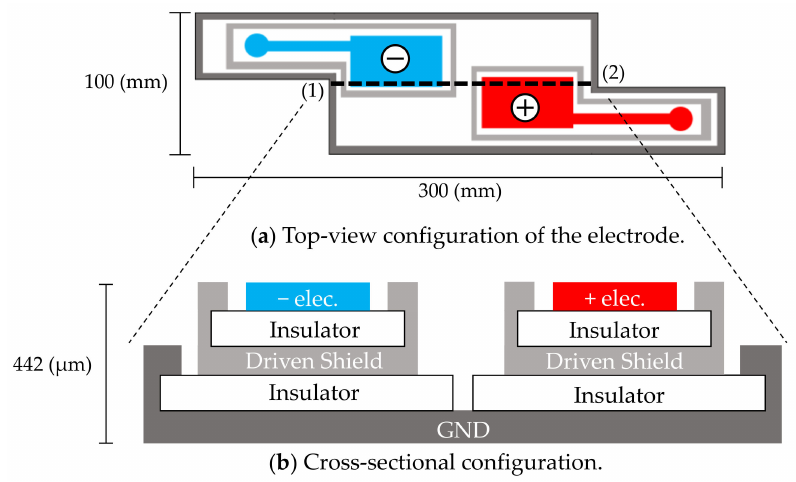
Figure 1. In-pillow capacitive cloth electrodes. ( a ) Top-view configuration of the electrodes. ( b ) Cross-sectional configuration of ( a ) along the dotted line (1)–(2). The electrodes have a five-layered structure. The top layers consist of a negative electrode ( − elec.) and a positive electrode